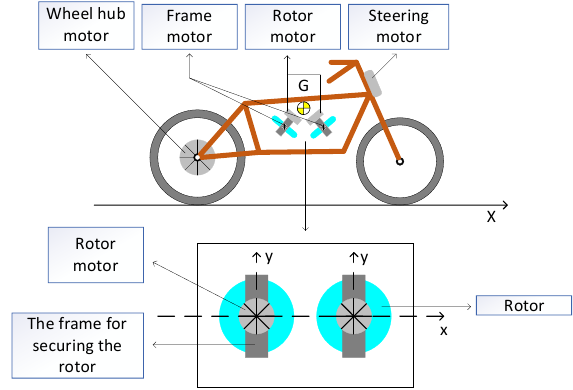
Figure 1. Structure of a two-wheeled motorcycle equipped with SGCMG.